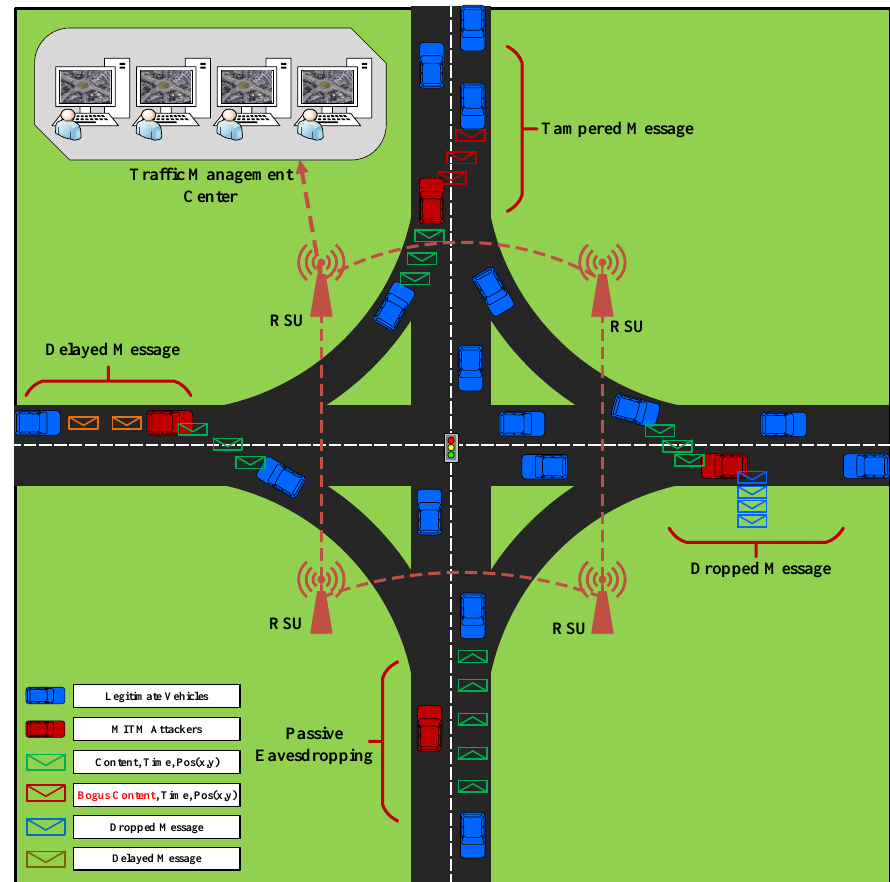
Figure 3. Illustration of Passive and Active MITM Attacks in